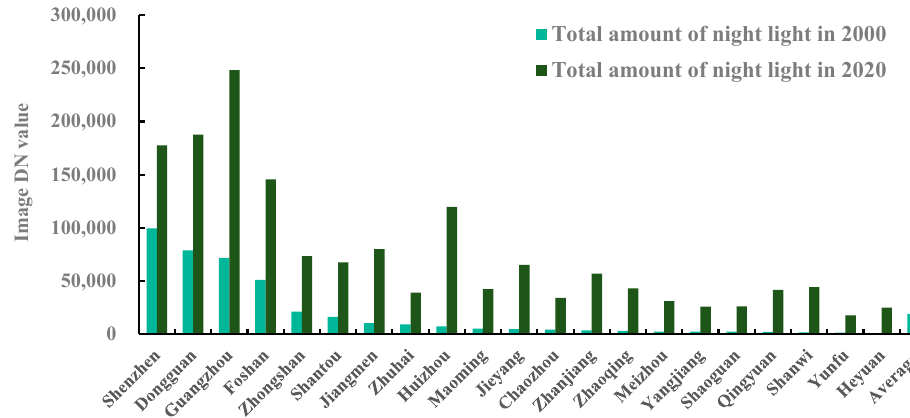
Figure 3. Total night lights from 2000 to 2020. ISPRS Int. J. Geo-Inf. 2022 , 11 , x FOR PEER REVIEW